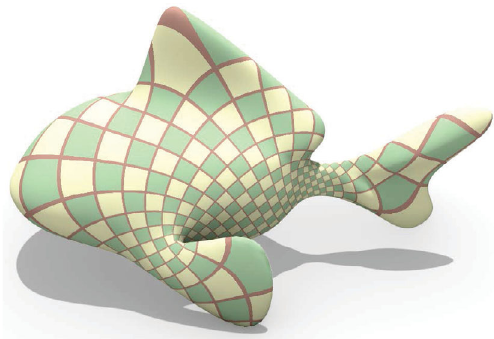
Fig. 11 Conformal parameterizations with large area